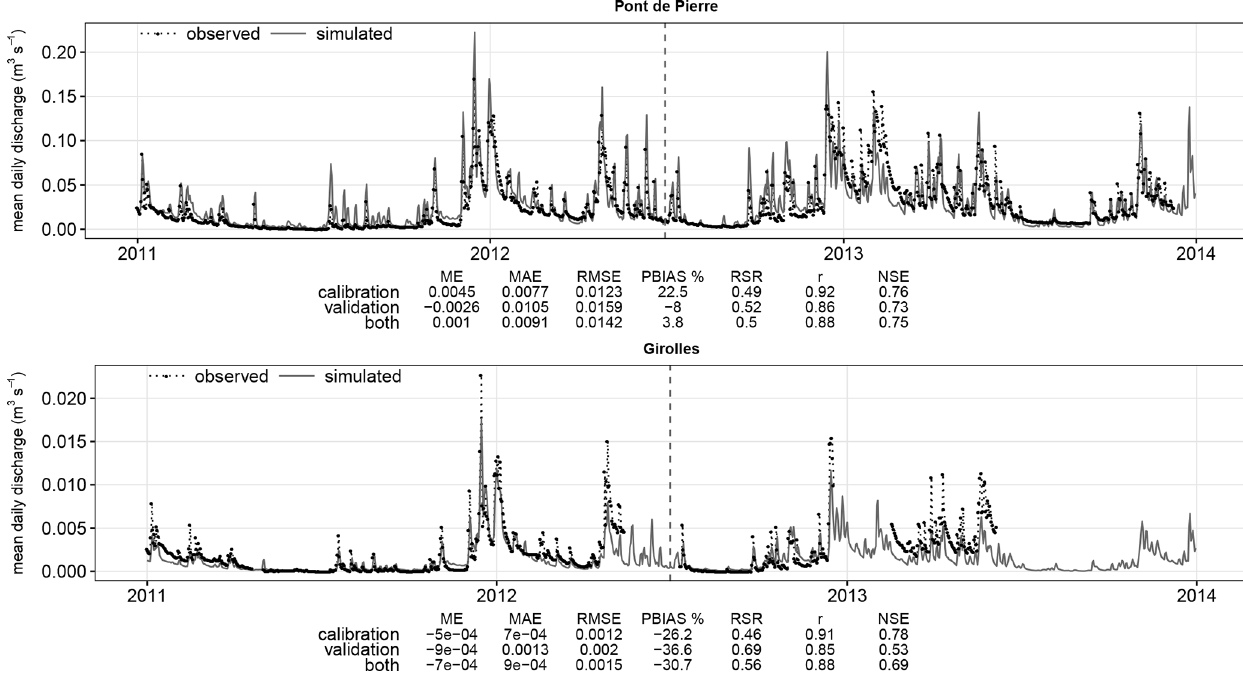
Figure 5. Observed and simulated stream discharge and model performance statistics for two selected locations within the Dauges catchment (1 January 2011–31 December 2013). Note different y -axis ranges.